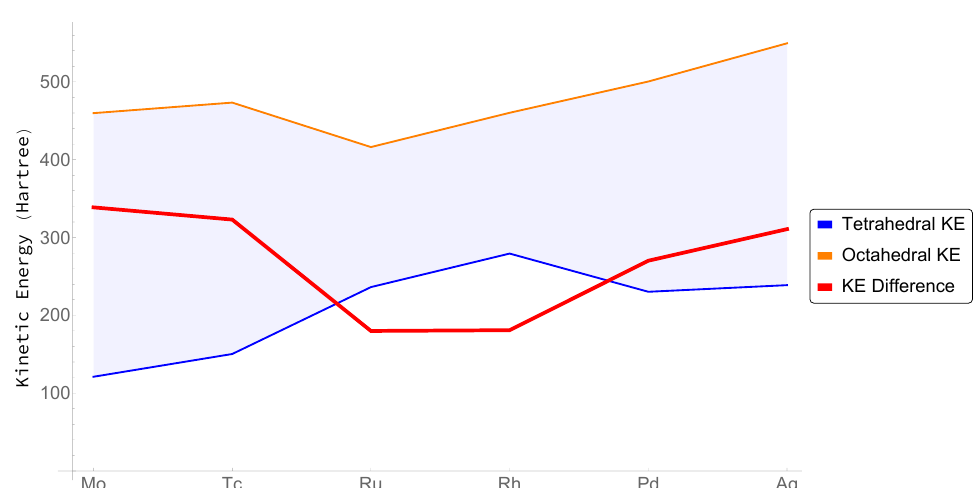
Figure 7. Integrated kinetic energy density (Hartree) in the Tetrahedral (Blue) and Octahedral (Orange) hole, and their difference (Shaded and Red). Lattice constants provided in Table A2.